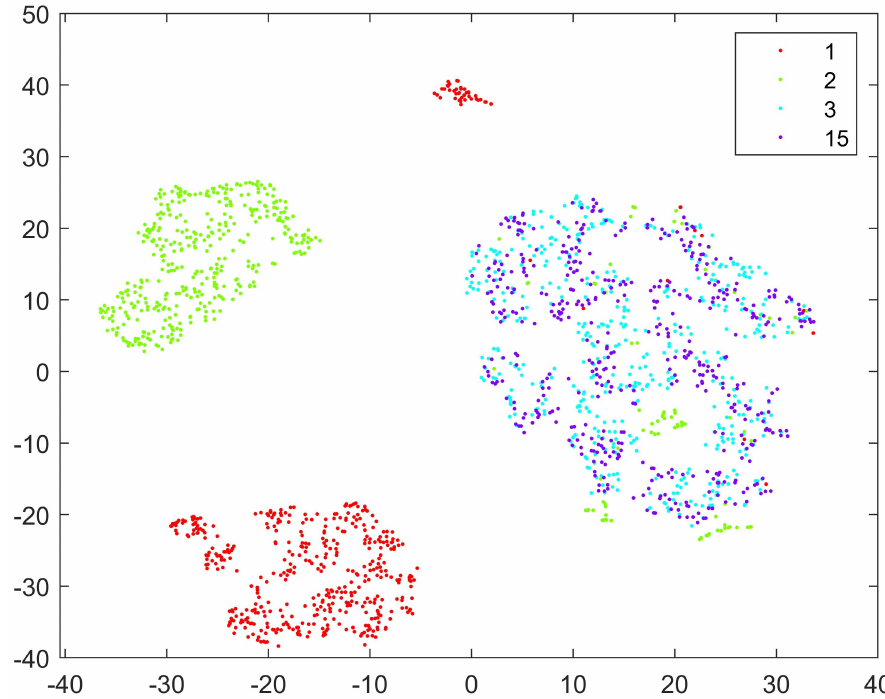
Figure 8. TSNE visual output of fault 1, 2, 3,